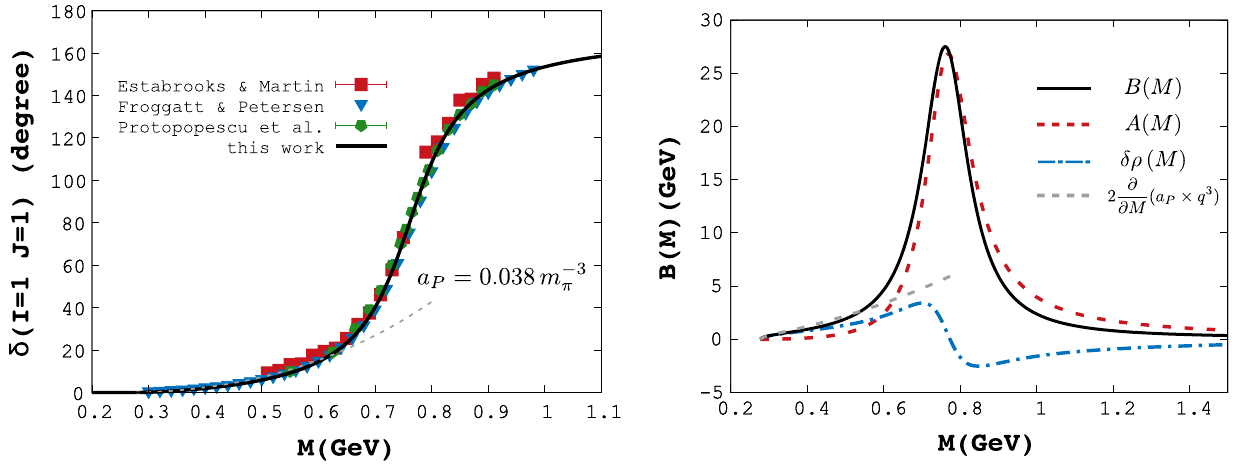
Fig. 1 Empirical phase shift data [12–14] and the corresponding effective spectral functions for the ρ -meson